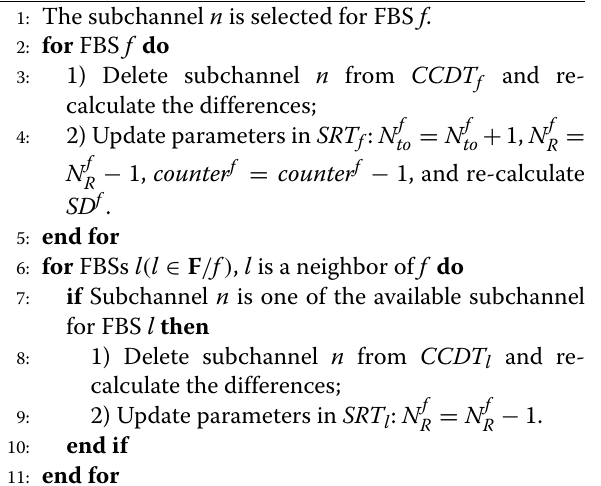
Algorithm 2 CCDT and SRT Table update